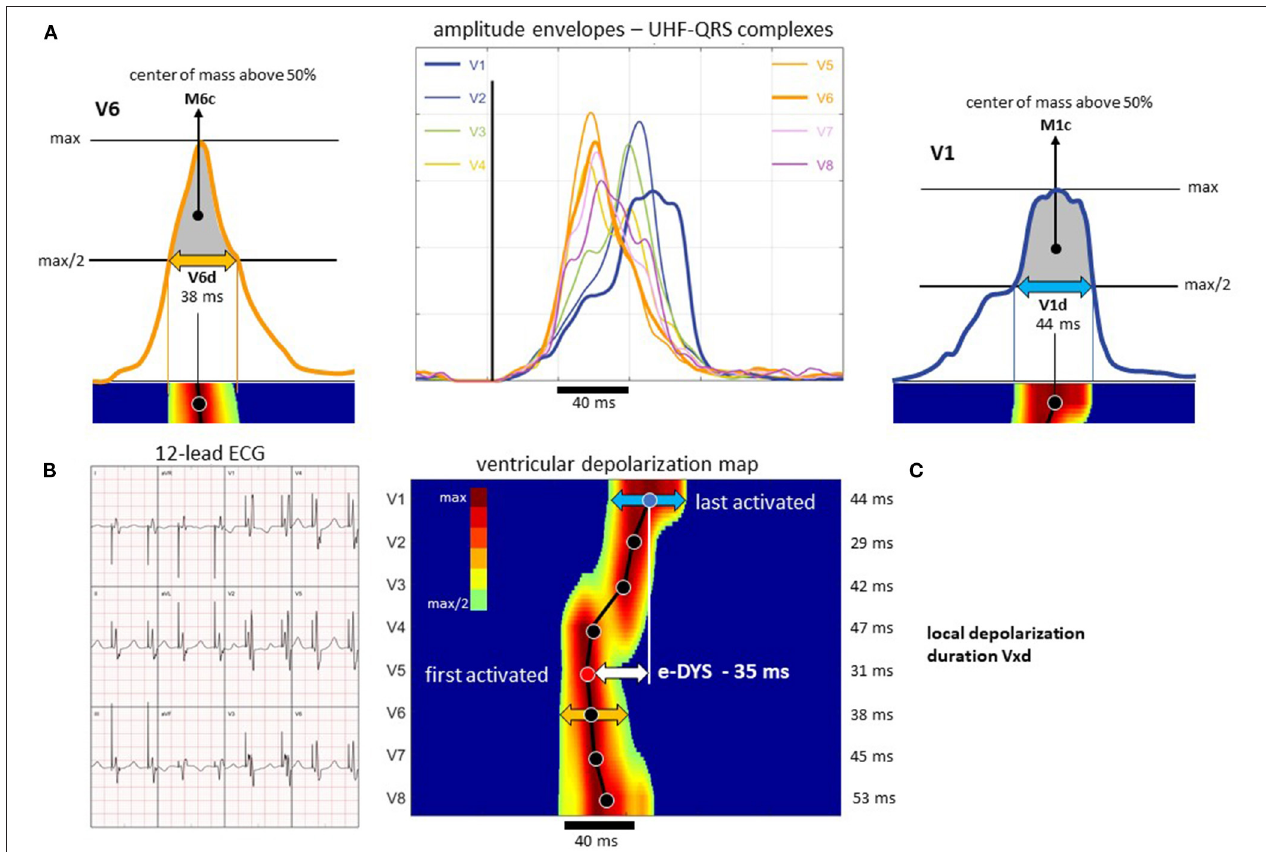
FIGURE 2 | Presentation of the UHF-QRS complexes, Mxc activation times, and Vxd local depolarization duration calculation; patient with sLBBp. (A) ultra-high-frequency amplitude envelopes of QRS complexes (UHF-QRS), Mxc computed as the center of mass above 50 percent threshold of the baseline to peak amplitude, Vxd determined as the depolarization duration at the 50 percent threshold of the baseline to peak amplitude. (B) 12-lead ECG. (C) Ventricular depolarization map with visualization of the M1-8c, electrical interventricular dyssynchrony e-DYS, and the V1-8d values. For details, see Jurak et al. (7). (C) The dark line connects the center of masses (solid points) under the specific lead (displayed on the y-axis). Time (ms) is displayed on the x-axis. In this case, the first activation occurred under V5 (M5c), and the last was under V1 (e-DYS = − 35ms). The width of depolarization under V1 is indicated by the blue arrow (V1d), under V6 by the orange arrow (V6d). The numerical parameters of the local depolarization duration (under each lead) are shown on the right side of (C) .